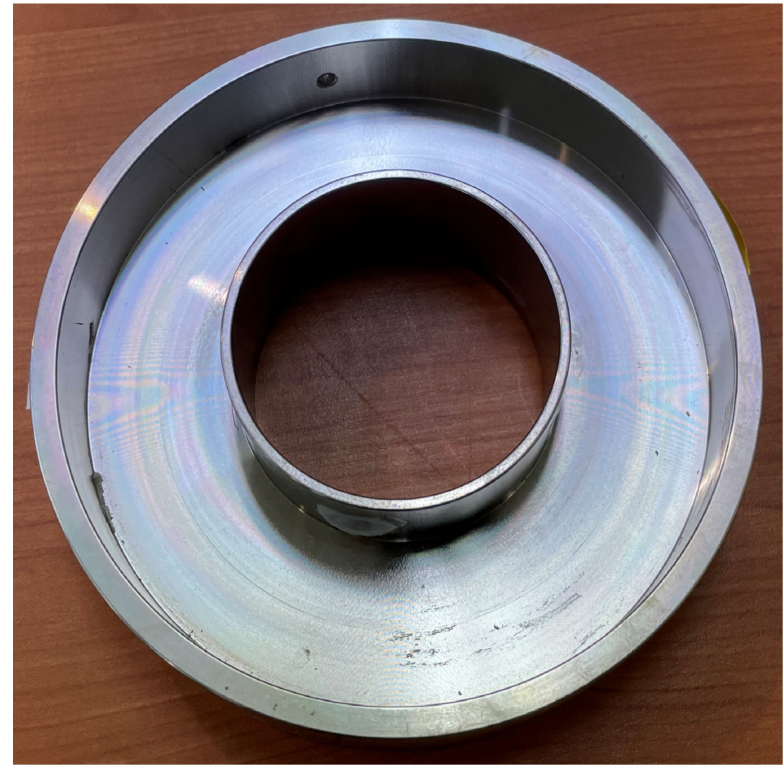
Figure 7. Prototype of elastic strain